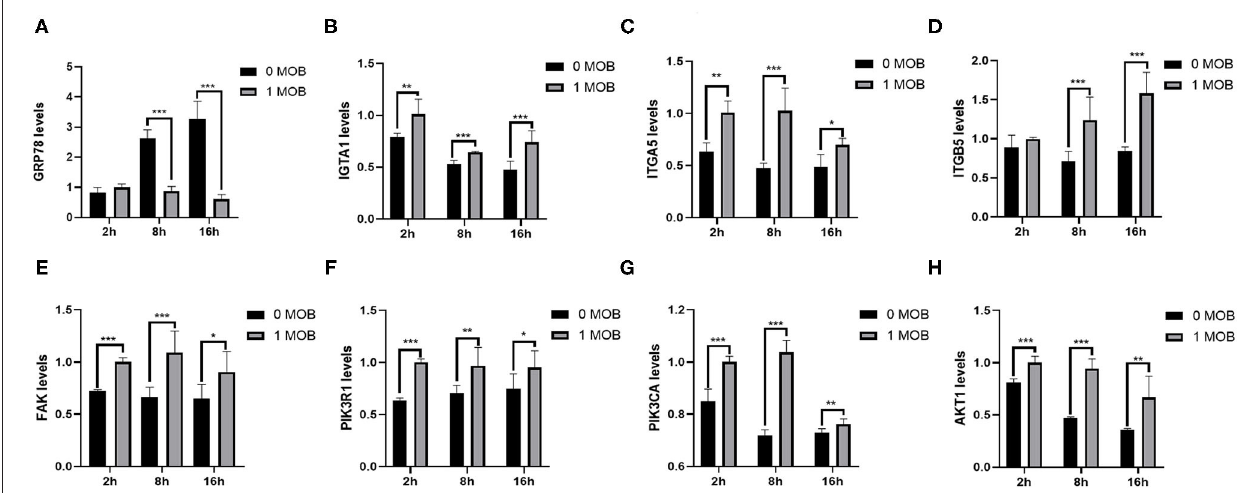
FIGURE 6 | Lactobacillus salivarius interfere with the expression of genes in IPEC-J2 cells. (A) The mRNA expression of GRP78 in untreated and L. salivarius- treated groups was detected by qPCR at different times post-PEDV infection. (B–H) The mRNA expression of seven genes ( ITGA1 , ITGA5 , ITGB5 , FAK , PIK3R1 , PIK3CA and AKT1 ) from the FAK/PI3K/Akt signaling pathway was examined in the two groups by qPCR at different times post-infection. The differences between the groups were analyzed using the t -test. Significant differences are marked with asterisks. *: p < 0.05, **: p < 0.01, ***: p <